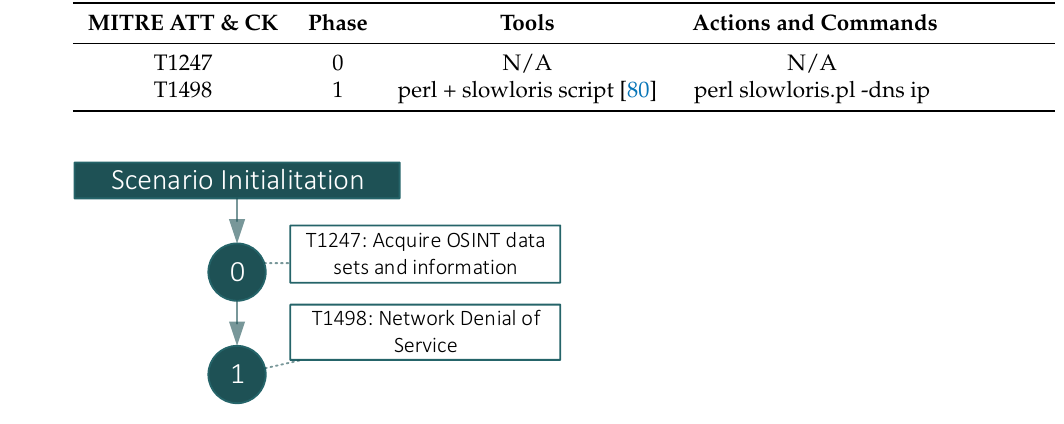
Figure 6. Scenario 2—Cyber kill chain for Webserver Denial of